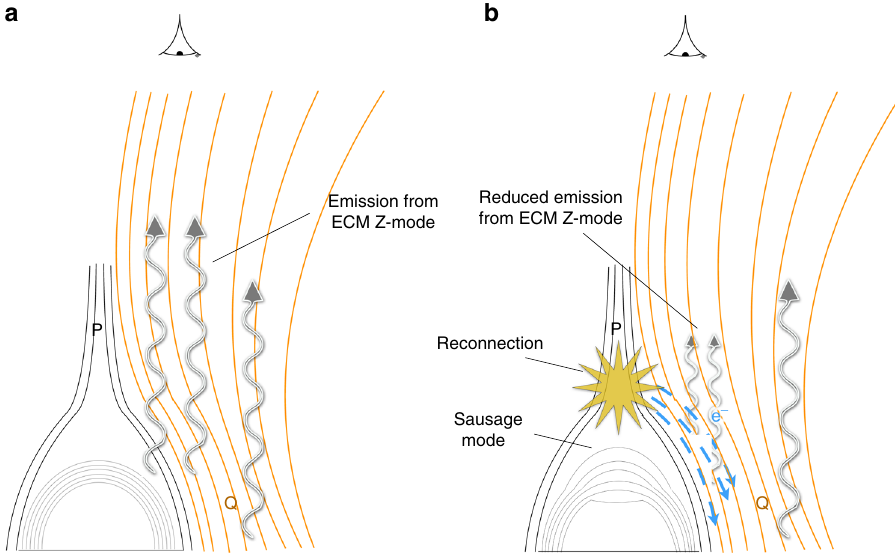
Fig. 8 Schematic of physical scenario in operation to produce the pulsations. a Electrons accelerated in the region initially form a loss-cone distribution at magnetic footpoints located around P and Q, resulting in loss-cone plasma emission (ECM Z-mode). b Establishment of an MHD sausage mode oscillation on the small loop results in acceleration of electrons at P (possibly via reconnection) due to modulation of the plasma conditions around the null point. Propagation of these electrons away from the null point (blue arrows) lead to reverse drift bursts from plasma emission. When the electrons reach the surrounding footpoints at P and Q, they quench the loss-cone instability, resulting in reduction of loss-cone emission. Some of the emission around Q remains unaffected. This would result in a radio emission modulation at the period of the sausage